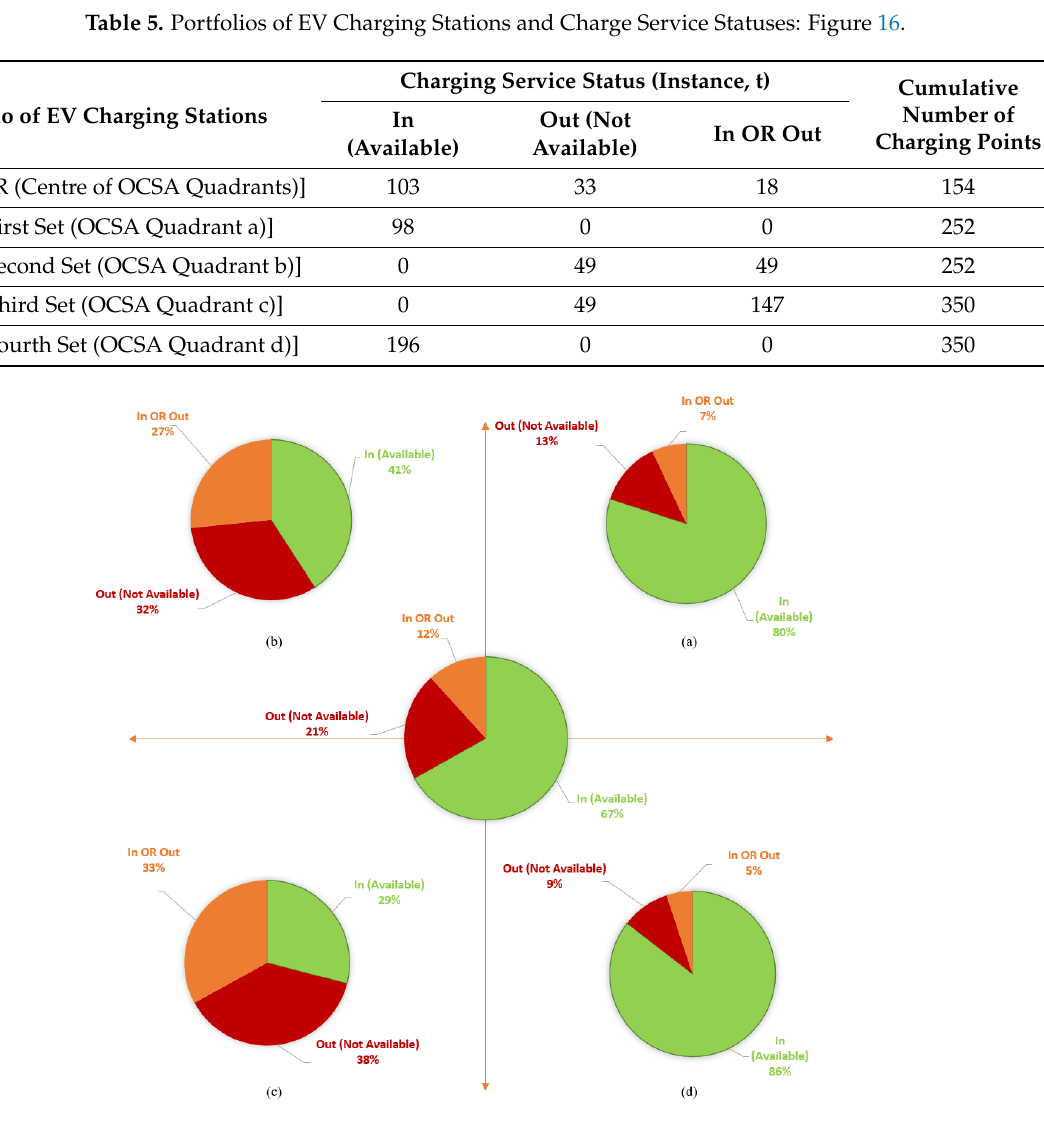
Figure 16. Overall Charging Station Availability (OCSA) Quadrants: When More Does/Doesn’t Mean Better: ( a ) Additional Working Charging Points; ( b ) Additional Defective Charging Points; ( c ) More and More of Defective Charging Points; ( d ) More and More of Working Charging